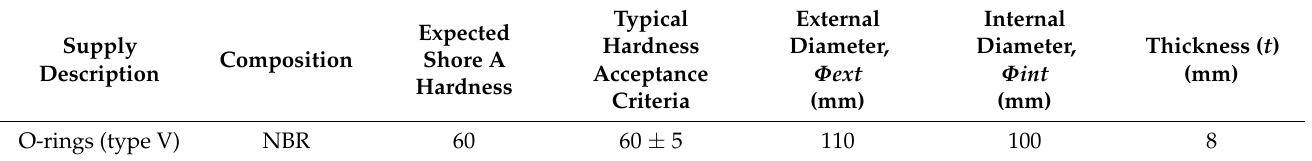
Table 1. Dimensional characteristics of O-rings.